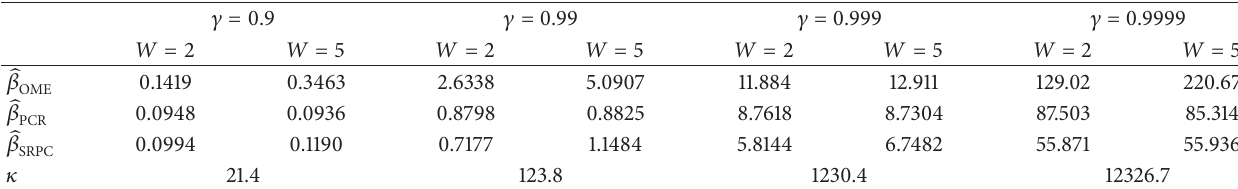
Table 2: Estimated MSE with 𝑛 = 100 .